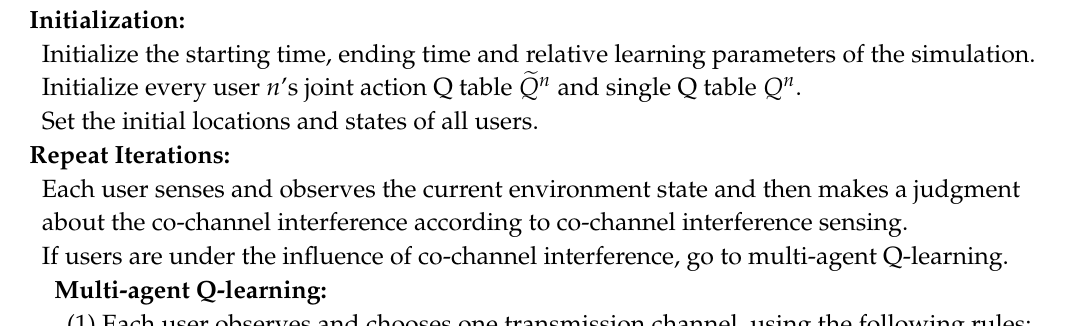
Figure 3. Anti-jamming distributed channel selection framework under different cases. Algorithm 1: Interference-aware cooperative anti-jamming distributed channel selection